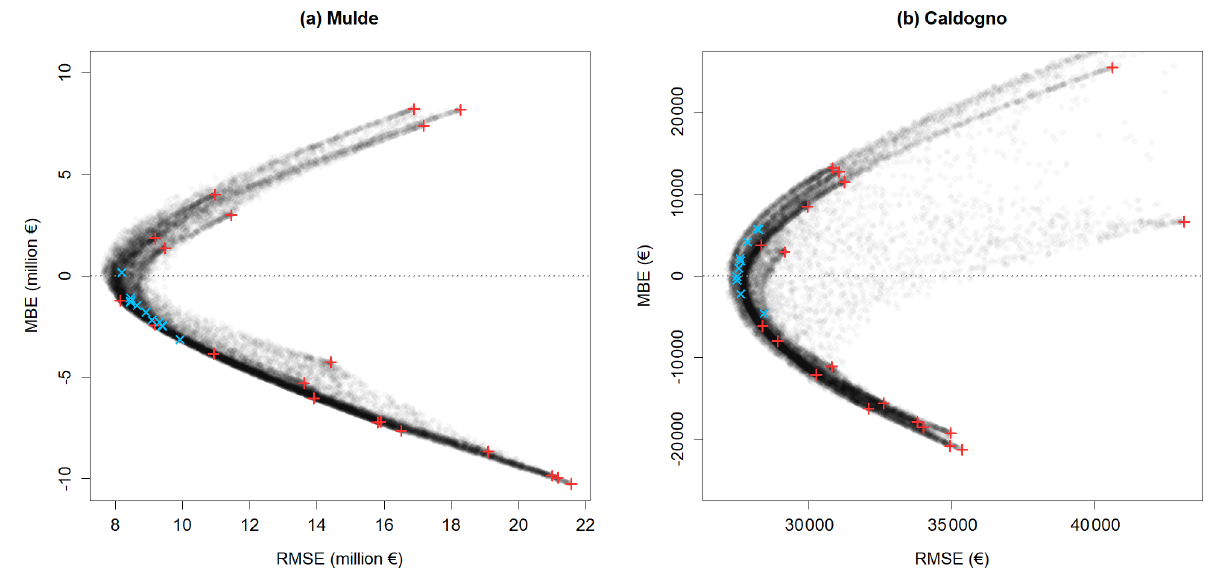
Figure 6. RMSE and MBE of 20000 multi-model ensemble means, generated by simulating a state of non-informativeness, whereby each participating member is assigned a random weight. Blue crosses and red plus signs refer respectively to the EEM-ensemble means and the single model predictions.